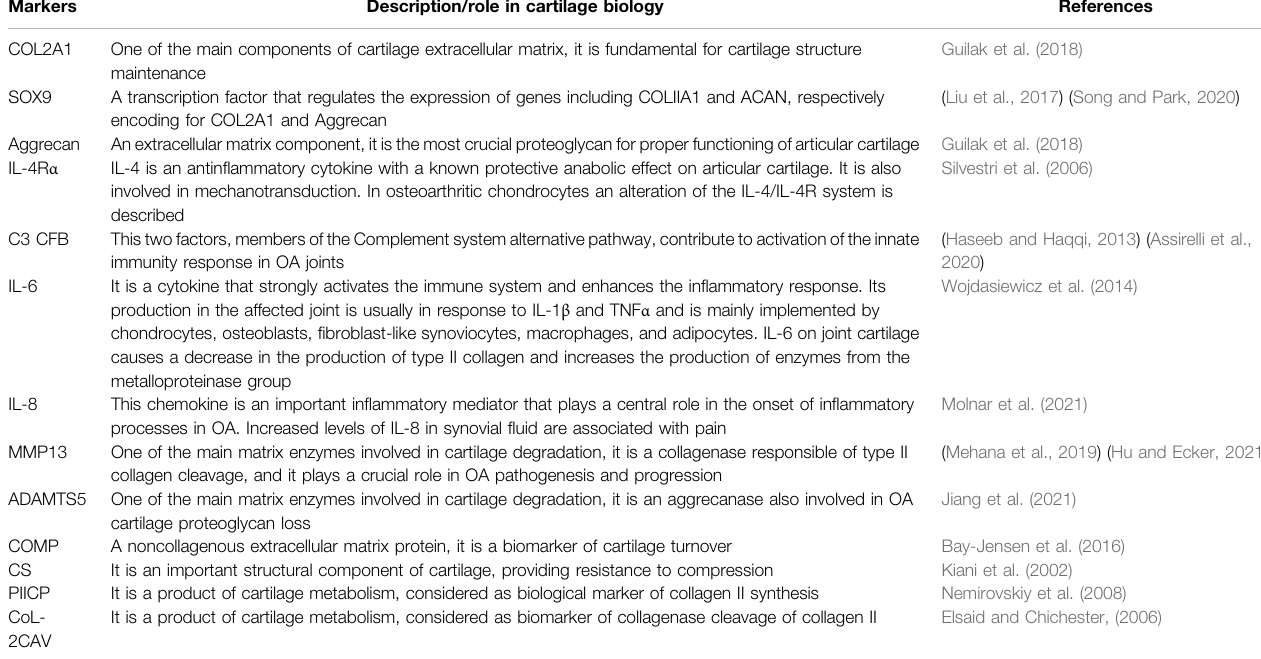
TABLE 1| Cartilage markers analysed fortheirgene expression orassoluble factors released inculture supernatants. Themainfunctionofeach marker incartilageturnover is reported.